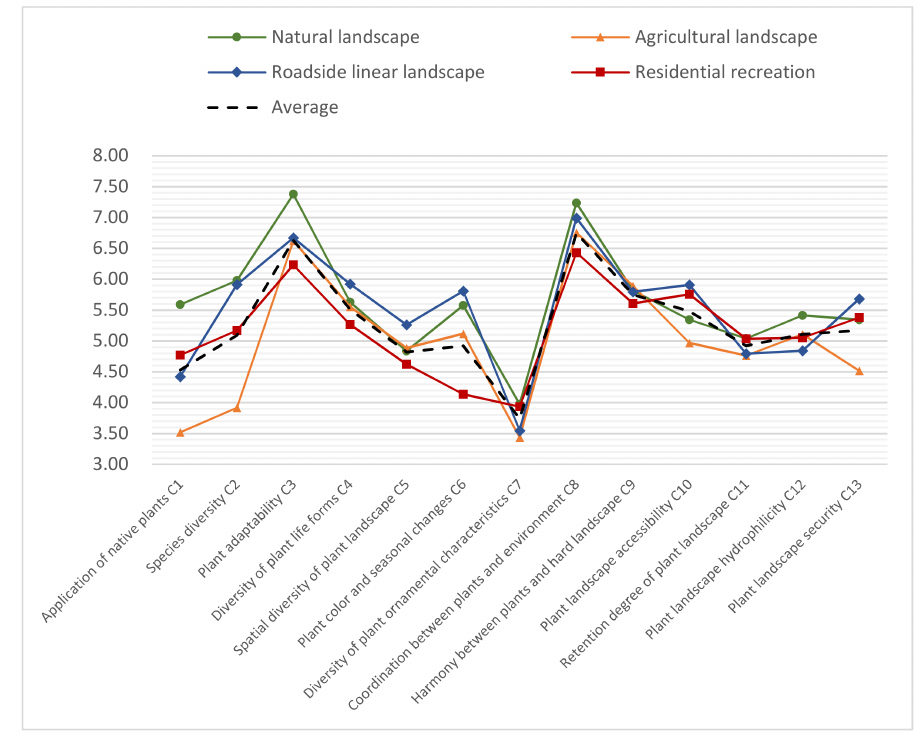
Figure 2. Landscape type and indicator layer analysis (source: